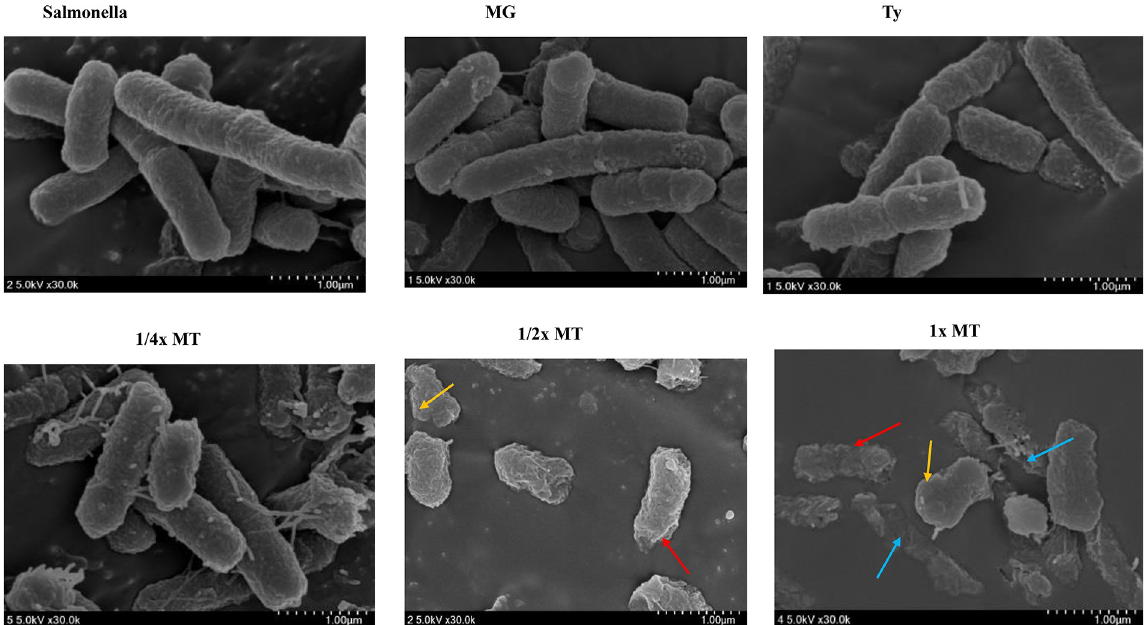
Fig 3. Scanning electron microscopic analysis of S . Typhimurium (ATCC 14028) treated with methyl gallate (MG), tylosin (Ty) and various concentrations of their combination (MT). Untreated control and Salmonella treated with MG, Ty and ¼× MT demonstrated intact morphology. S . Typhimurium treated with 1x MT and ½ x MT showed altered morphology and leakage of cellular contents. Salmonella : non- treated S . Typhimurium. MG = 128 μ g/mL; Ty = 256 μ g/mL; ¼× MT = 32 μ g/mL MG and 64 μ g/mL Ty; ½× MT = 64 μ g/mL MG and 128 μ g/ mL Ty; and 1 × MT = 128 μ g/mL MG and 256 μ g/mL